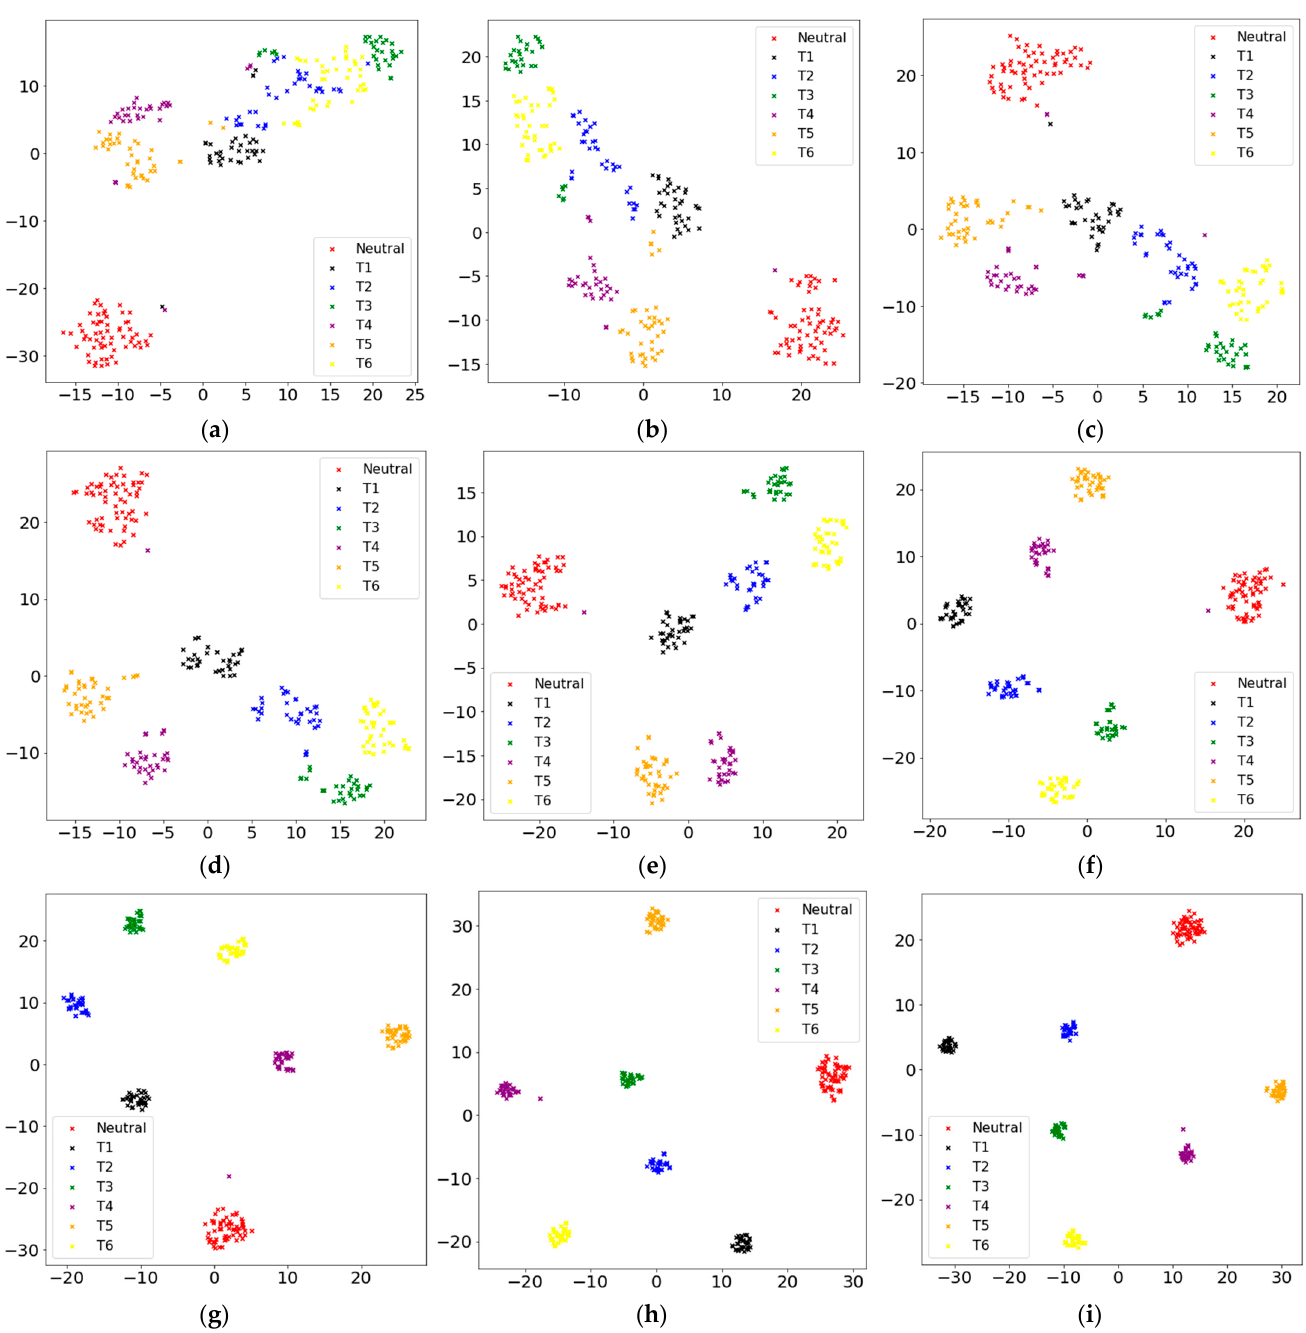
Figure 6. Visualization of deep features extracted from all subjects and the scattered points represent samples with colors to indicate different motions: ( a – i ) Visualization of deep features when λ is set as 0, 5 × 10 − 6 , 1 × 10 − 5 , 1.5 × 10 − 5 , 2 × 10 − 5 , 1 × 10 − 4 , 2.5 × 10 − 4 , 5.0 × 10 − 4 , and 1 × 10 − 3 respectively.